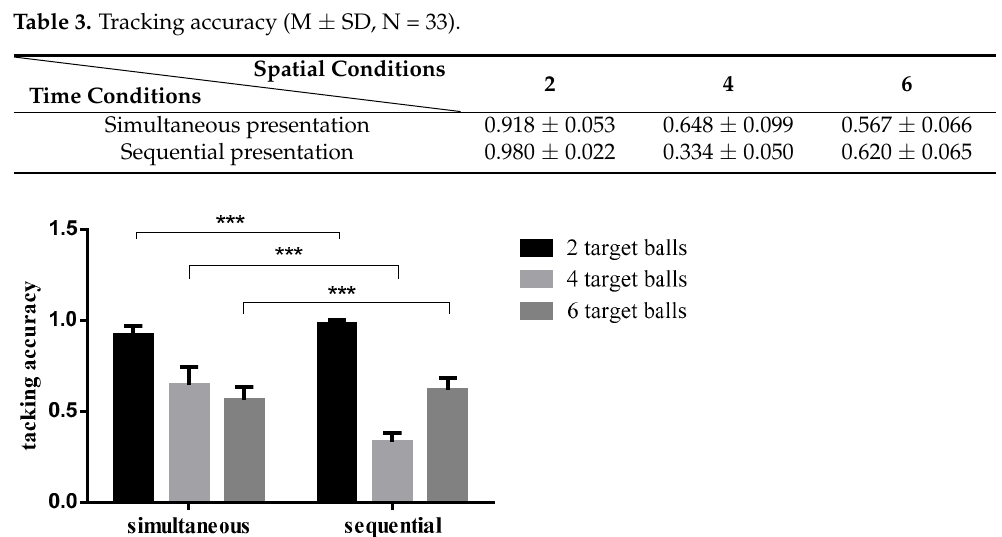
Figure 7. Comparison of the accuracy rate of different numbers of target balls in the simultaneous and sequential conditions. Note: *** indicates the significance level is p < 0.001.